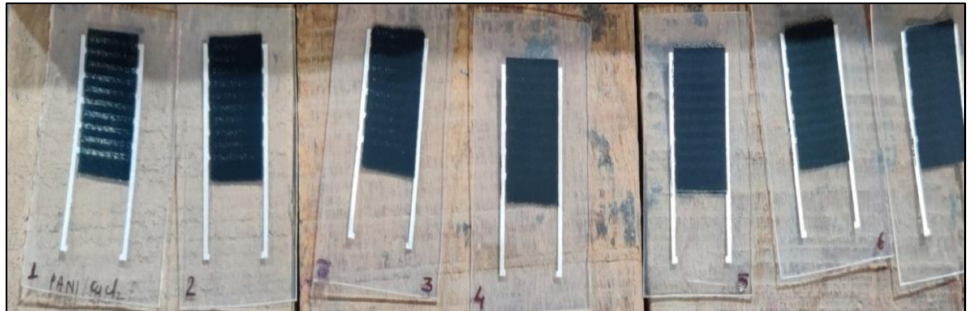
Figure 19. PANI/CuCl 2 screen-printed films with varying number of